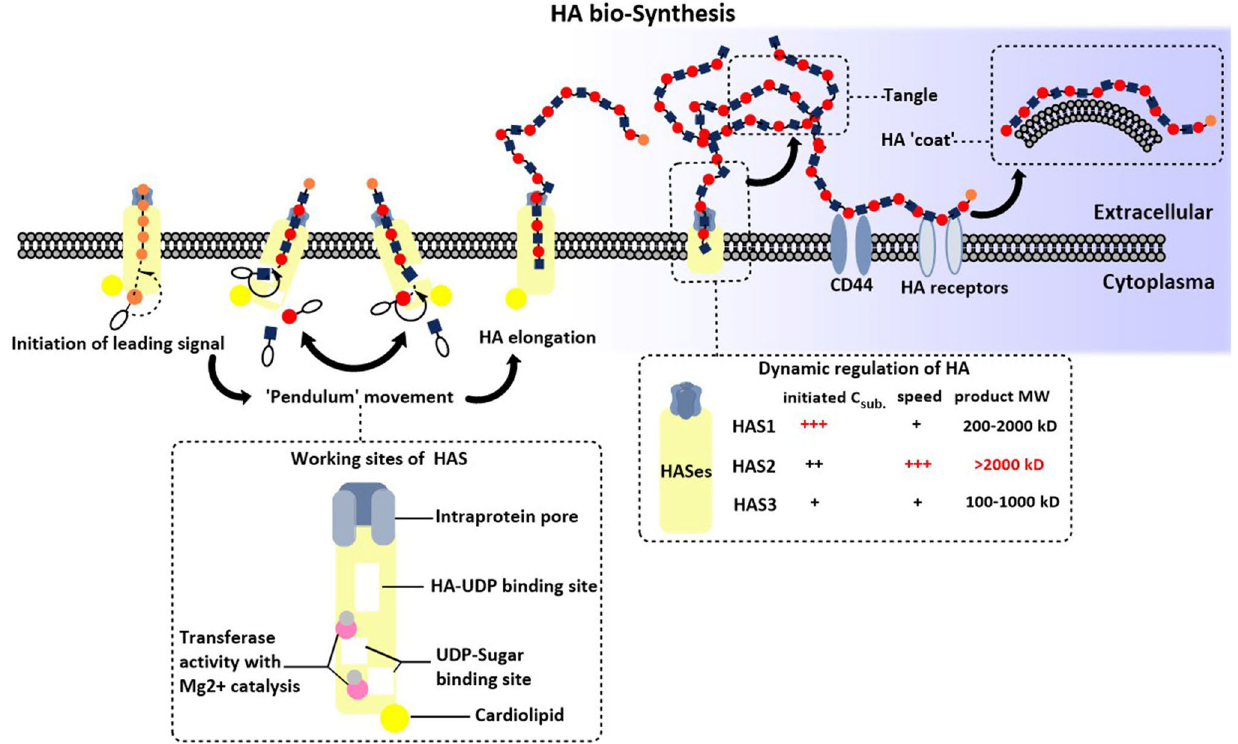
Fig. 1 The bio-synthesis of HA. The process of HA synthesis in the ‘Pendulum’ movement pathway starts from the initiation of the leading signal, a chitin primer connecting 6 constant GlcNAc. Two substrates of UDP-sugars, UDP-GlcNAc and UDP-GlcUA were recruited to the membrane, and generated linear polymers connecting with GlcUA-(1,3)-GlcNAc -β(1,4)-GlcUA-bond. The residue addition synthesis was produced inside the HAS, and was delivered by transferase under Mg 2+ catalysis. The HA polymers were extruded through intra-protein pore of HAS, hanging out of the extracellular space nearby the membrane or folding as tangle through the intra-molecular and intermolec- ular H-bonds. Different HA receptors recognized specific HA polymers with different molecule weights. For example, CD44 captured HMW- HA and formed HA ‘coat’ on the external surface of cells. The lower left box with dash line indicates the detail and specific position of HAS how it produces the HA synthesis. The lower right box with the dash line indicates the working requirement and products of HA synthesis when three HAS isoforms, HAS1, HAS2, HAS3, start dynamic